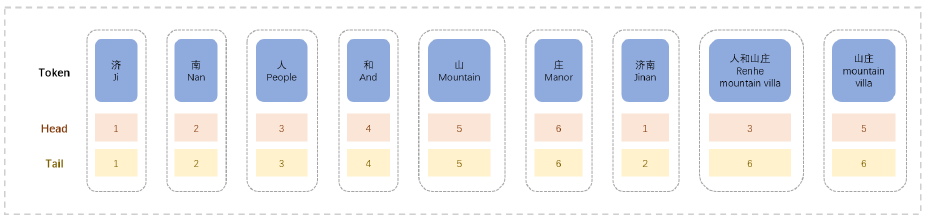
Figure 8. Structure diagram of Flat-lattice.